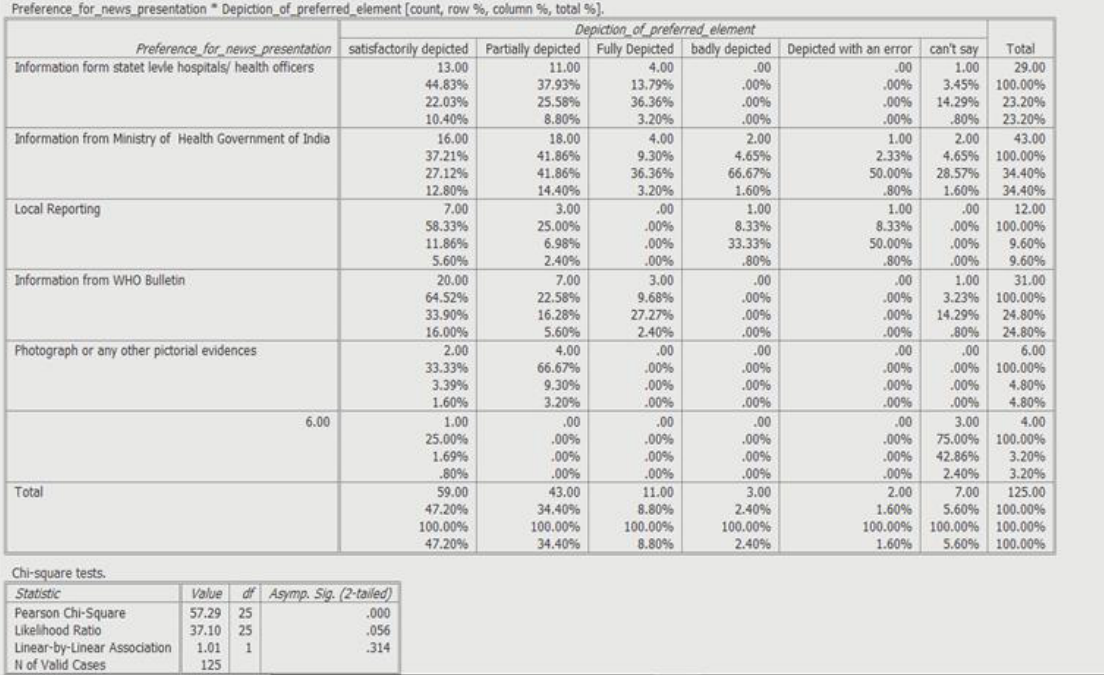
Figure 12: Cross tabulation and Chi-square between News Content Preferred v/s Newspaper Content Depicted (Source: Authors‟